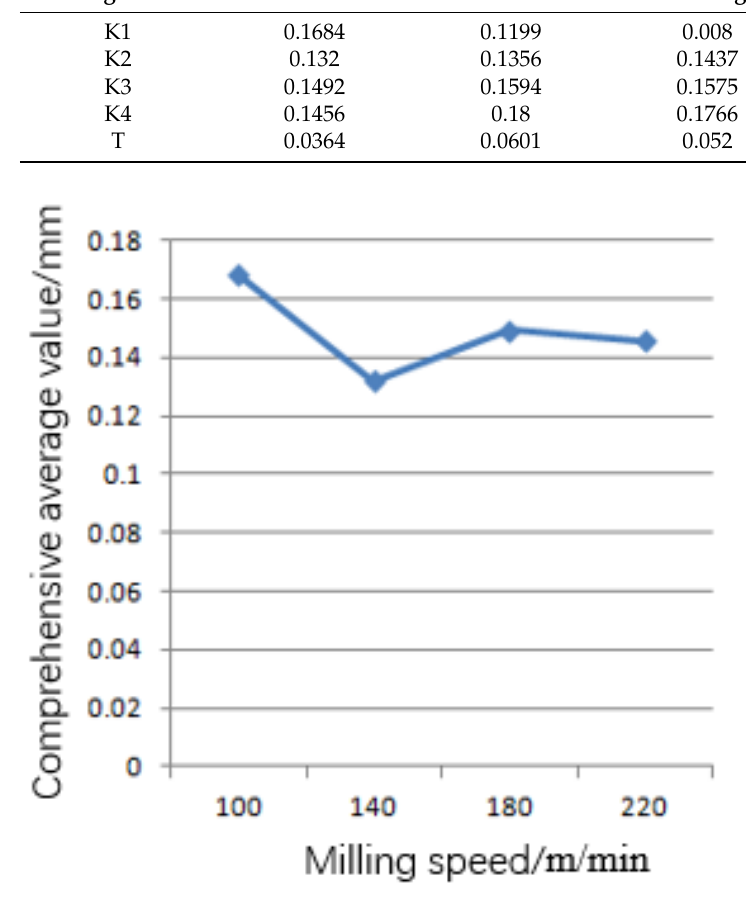
Figure 6. Influence on deformation of different milling speeds.